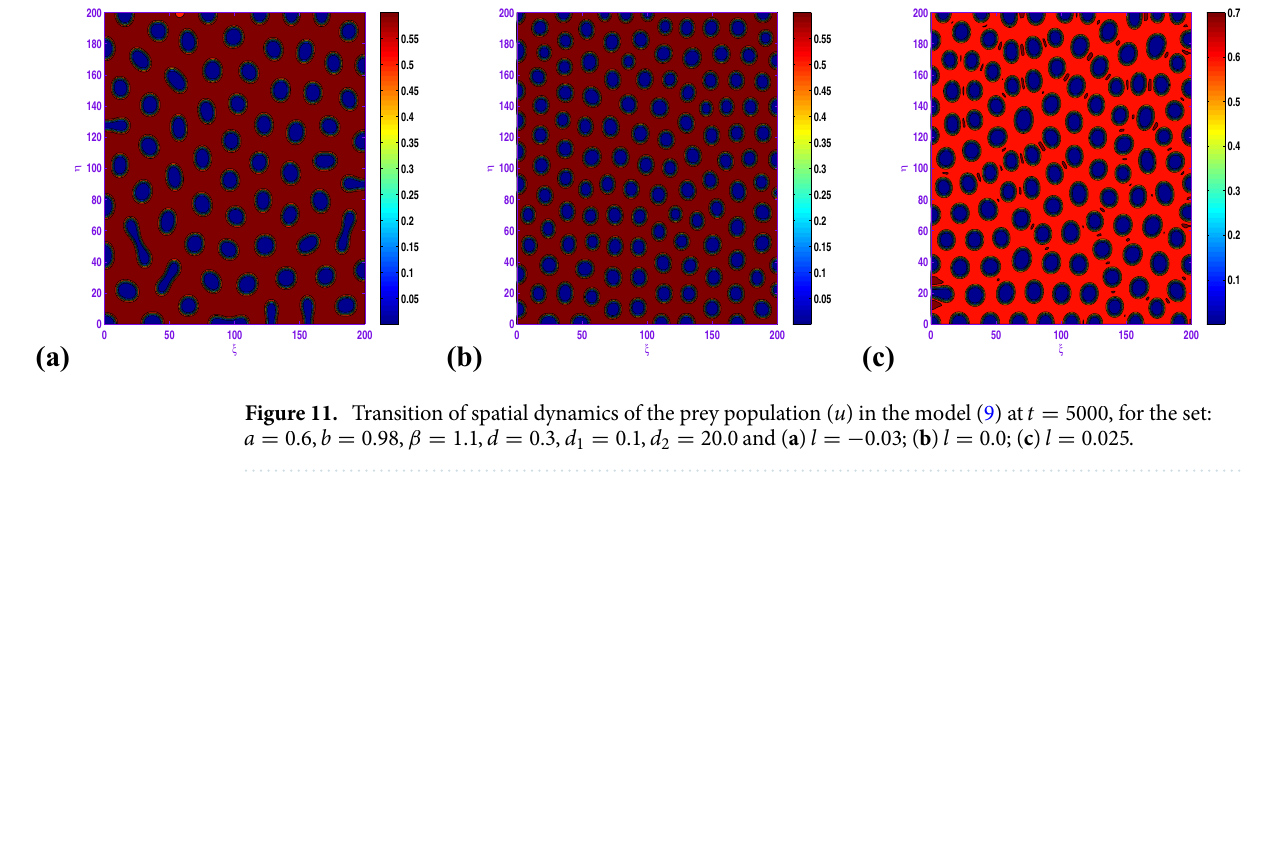
l = − 0.01 ; ( b ) l = 0.04 . d 1 = 0.1 , 2 = 20.0 and ( a )